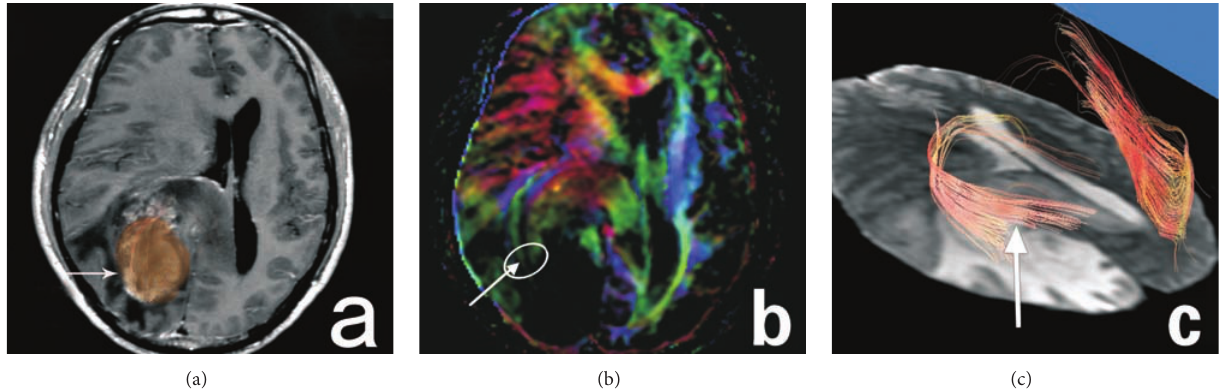
Figure 2: The contrast T 1 WI image of right occipital lobe gliomas in a 55-year-old man ((a), arrow). The FA value of the right GCT decreases significantly and it can not be identified in the DEC map ((b), arrow). DTT map shows disruption and infiltration of the right GCT fibers ((c), arrow).